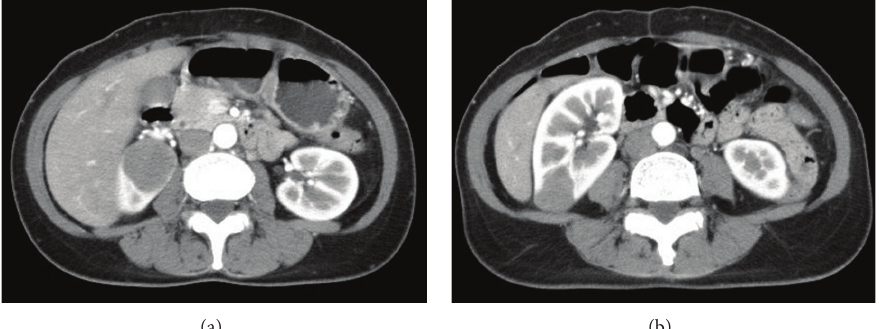
Figure 1: Abdominal computed tomography (CT) scan. Abdominal CT scan enhancement showed hypovascular tumors at upper poles (a), lower poles (b), and middle portions of the right kidney.